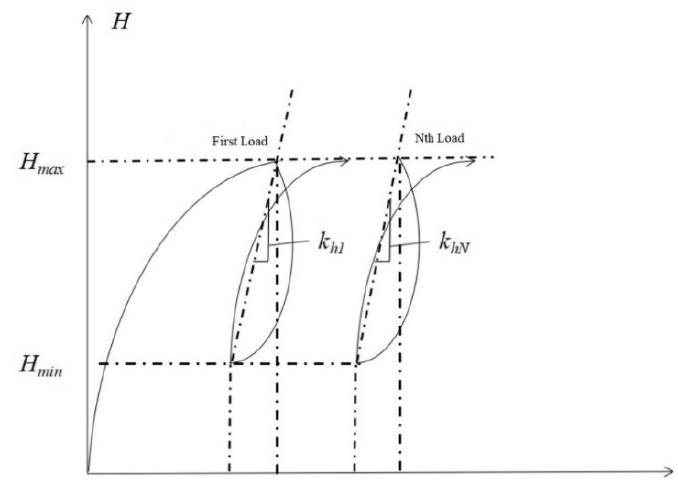
Figure 5. Calculation method for lateral cyclic stiffness of pile.